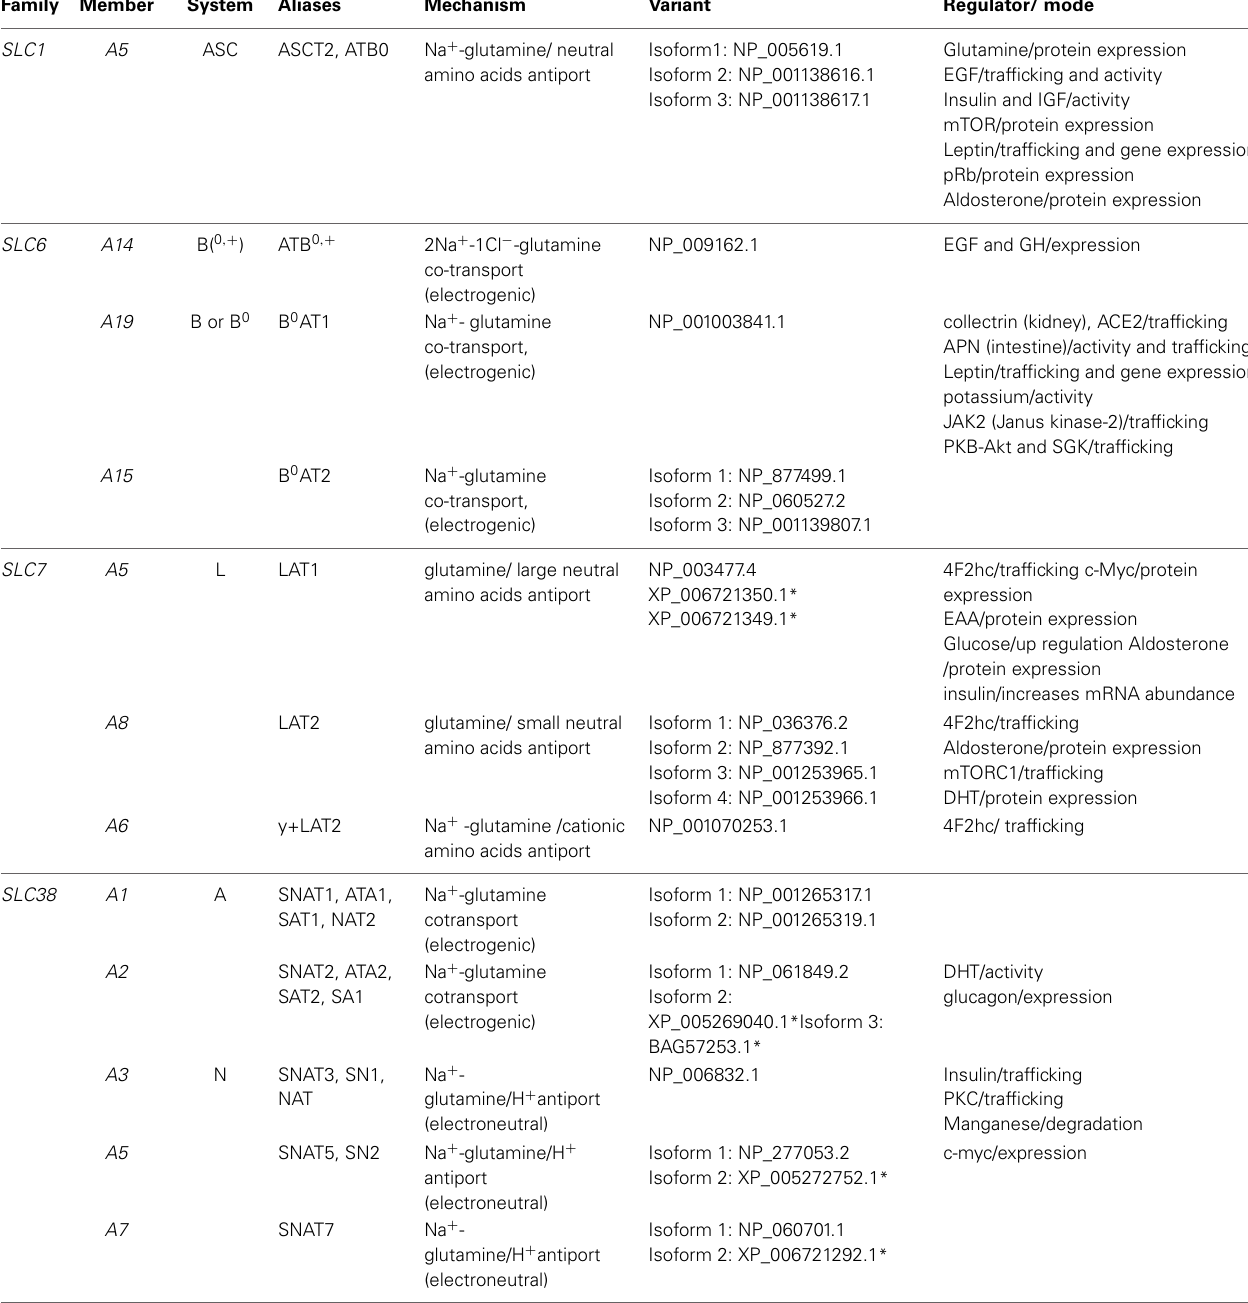
( Figure 3 ) for further advancement of the knowledge on the glutamine transporter function and